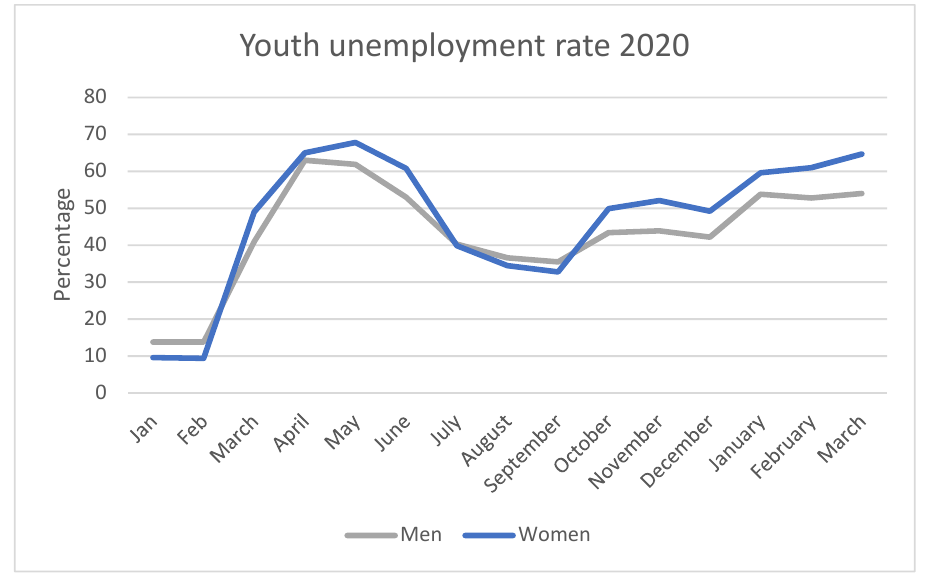
Figure 2. The unemployment rate of those aged 15–24 in Ireland between January 2020 and March 2021. Source: Central Statistics Office.